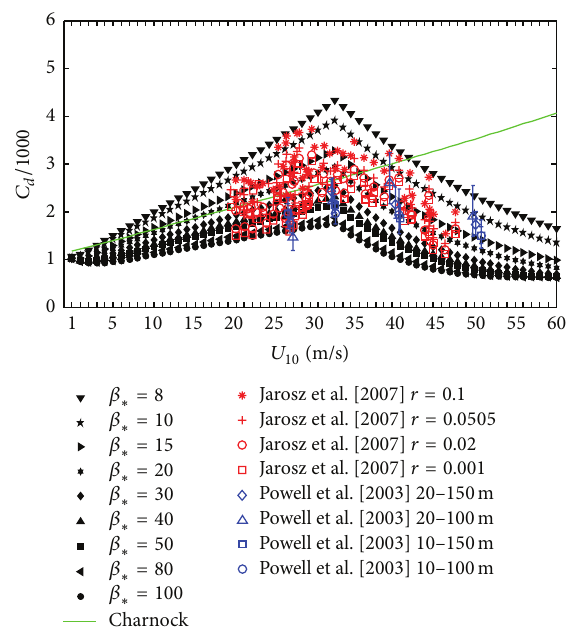
Figure 2: The change of drag coefficient with the 10m wind speed on the different wave ages (8, 10, 15, 20, 30, 40, 50, 80, and 100). The black dot lines represent the drag coefficient affected by the sea spray, which are calculated by (13). The drag coefficient without the effect of sea spray is indicated by the green line and calculated by the Charnock relation (9). The observations of Jarosz et al. (2007) based on different resistance coefficients (0.1, 0.0505, 0.02, and 0.001 cm/s) are plotted by the red dots. The blue dots represent the drag coefficient observed by Powell et al. (2003).